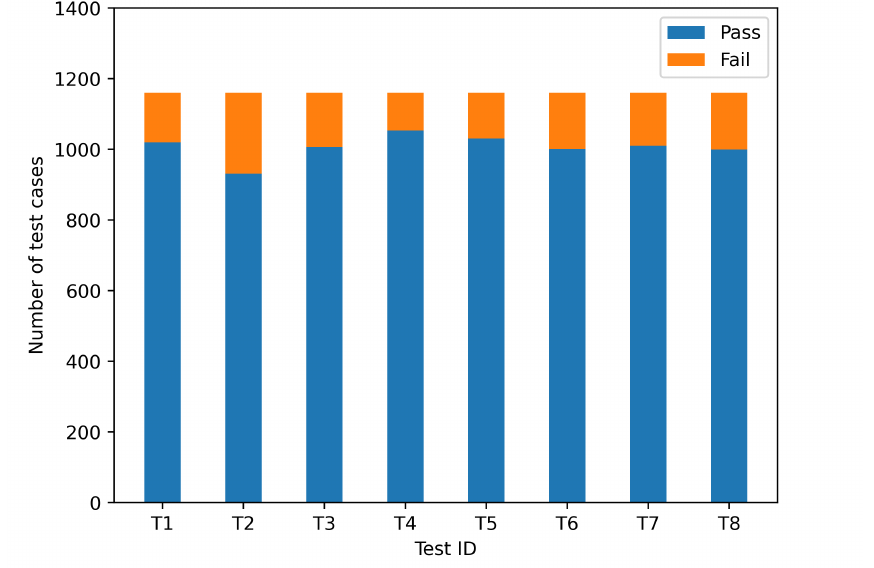
Figure 16. Comparison of ICW test pass rates with 1160 cases.